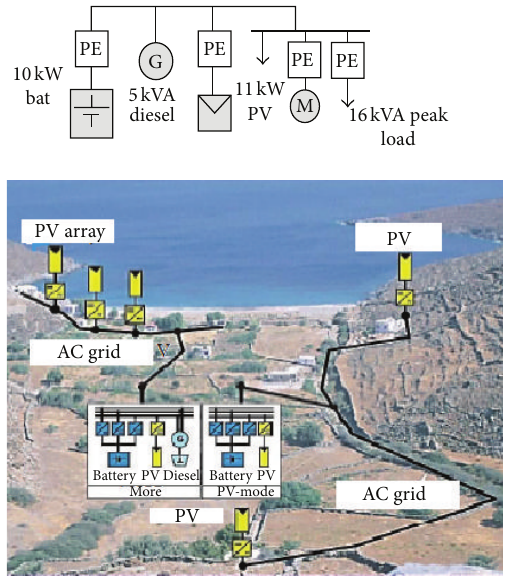
Figure 2: 𝜇 G system with PV, diesel, and storage [7].